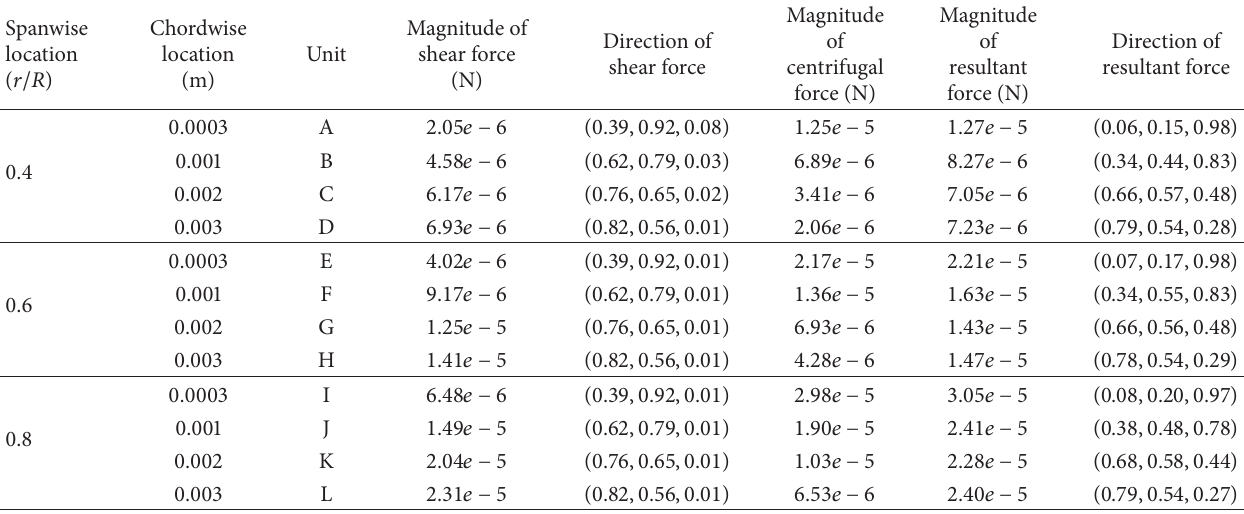
Table 2: Force analysis of each unit.